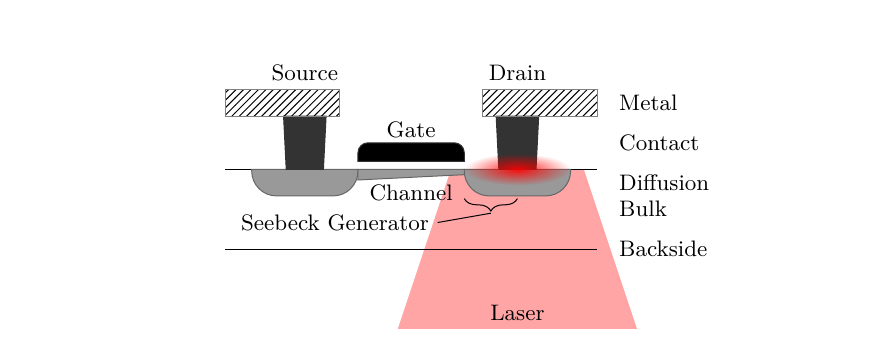
Figure 2: Seebeck voltage generation in a MOSFET transistor. Figure based on